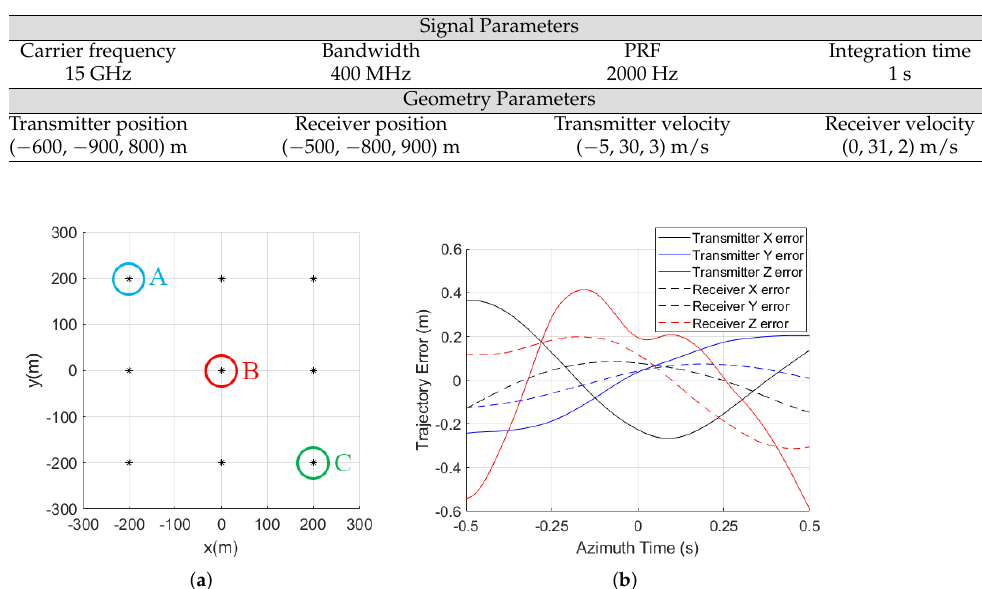
Figure 5. Simulation parameters: ( a ) simulation scene and scatters selected for analysis; ( b ) simulated bistatic SAR motion error.